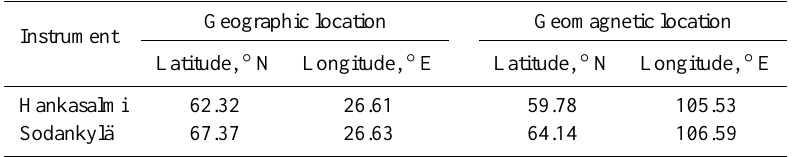
Table 1. Geographic and geomagnetic locations of the instrumentations.